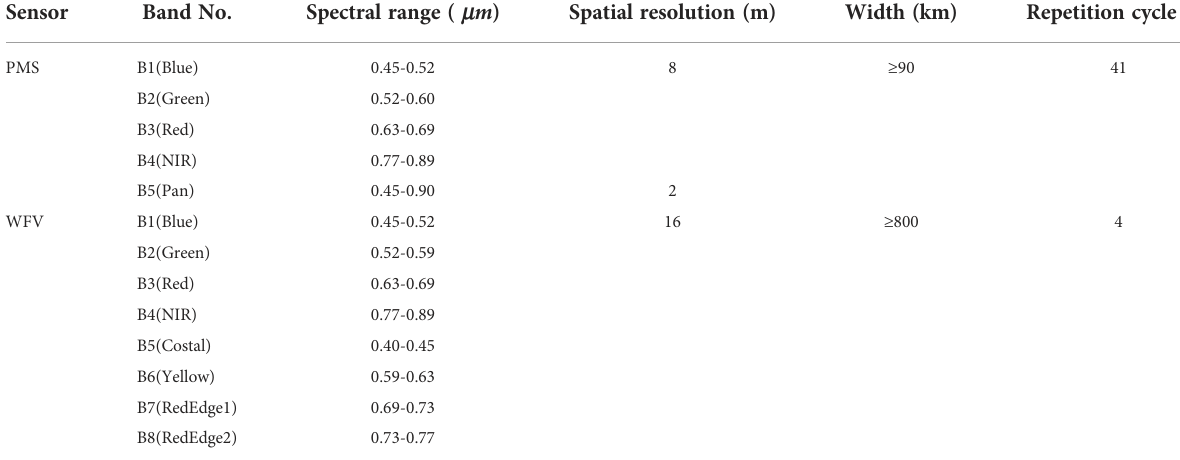
TABLE 1 Information of GF-6 PMS and